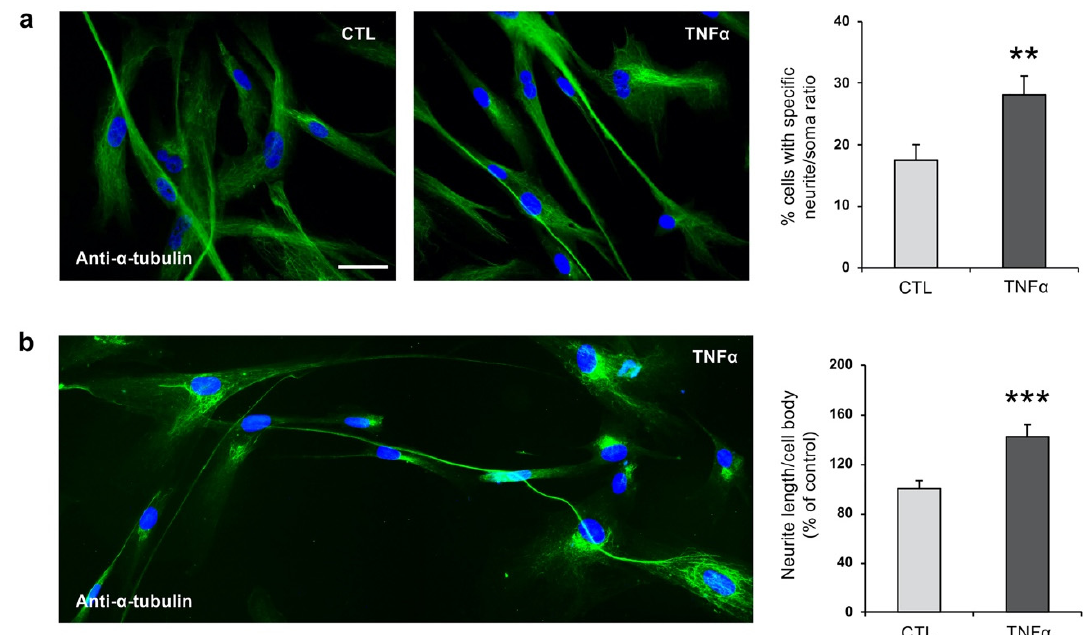
Figure 2. TNF α increases neurite outgrowth in hfNBMs. ( a , b ) Representative images (left) and graph (right) showing ( a ) neurite outgrowth count and ( b ) length by α‐ tubulin staining in untreated (CTL)